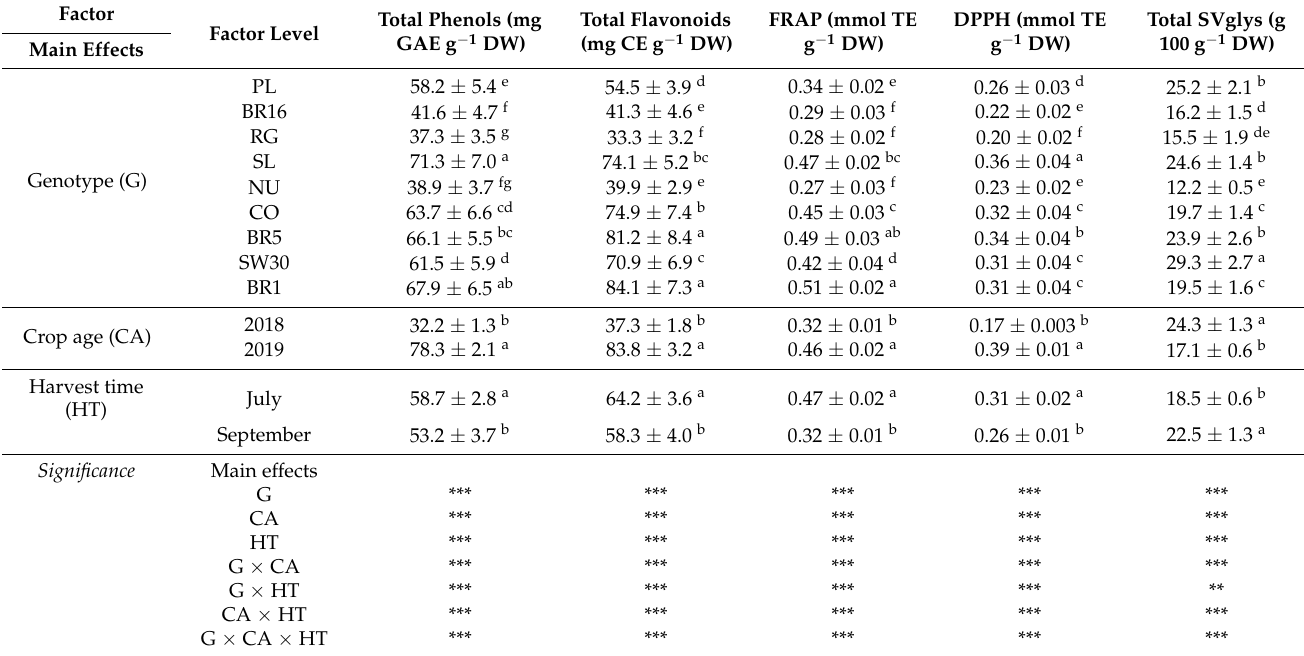
Table 5. Results of three-way ANOVA for secondary metabolites (total phenols, flavonoids, and steviol glycosides) and antioxidant activities of stevia leaf extracts.